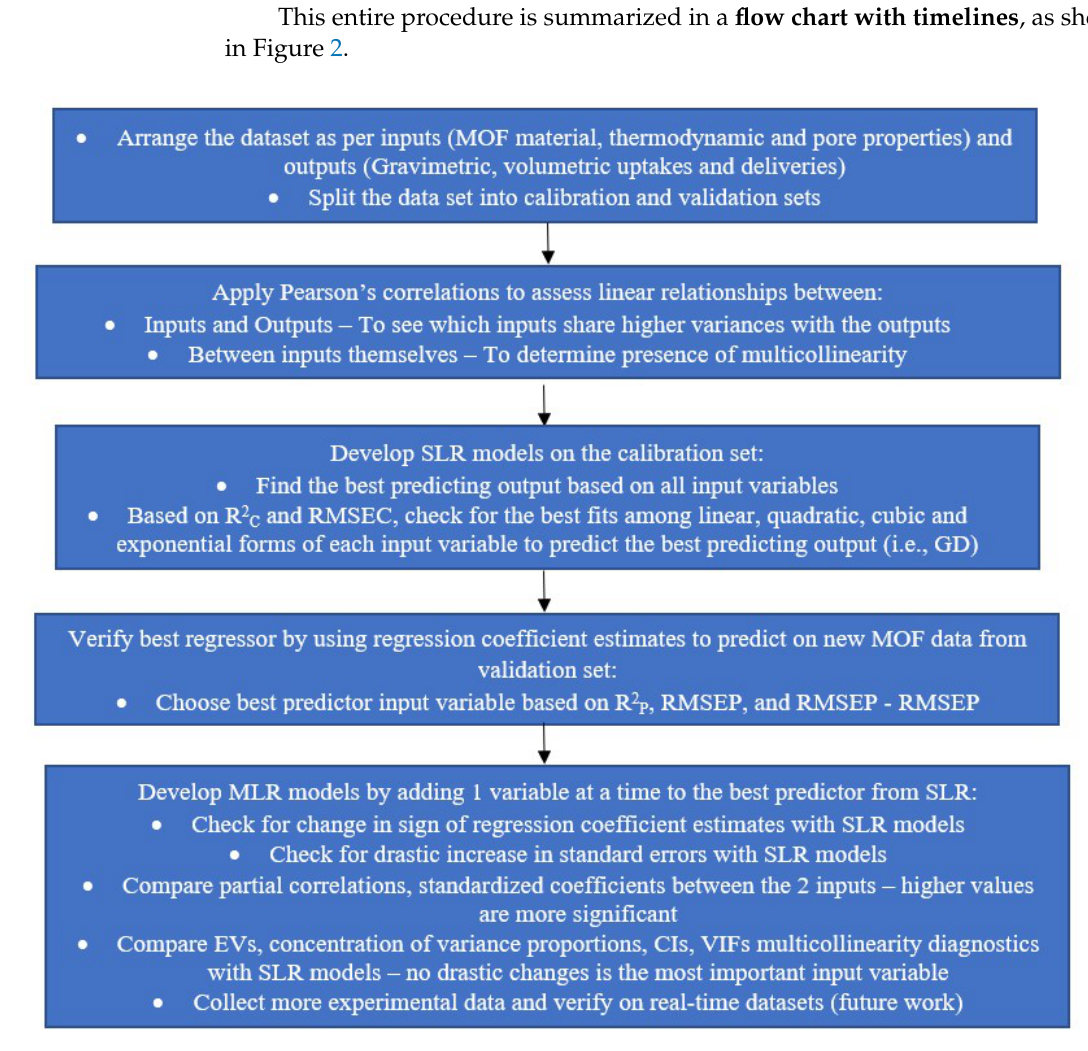
Figure 2. Step-by-step procedure for the statistical analyses followed in this work to find the most important MOF material or pore property that has the maximum influence on methane storage performance.